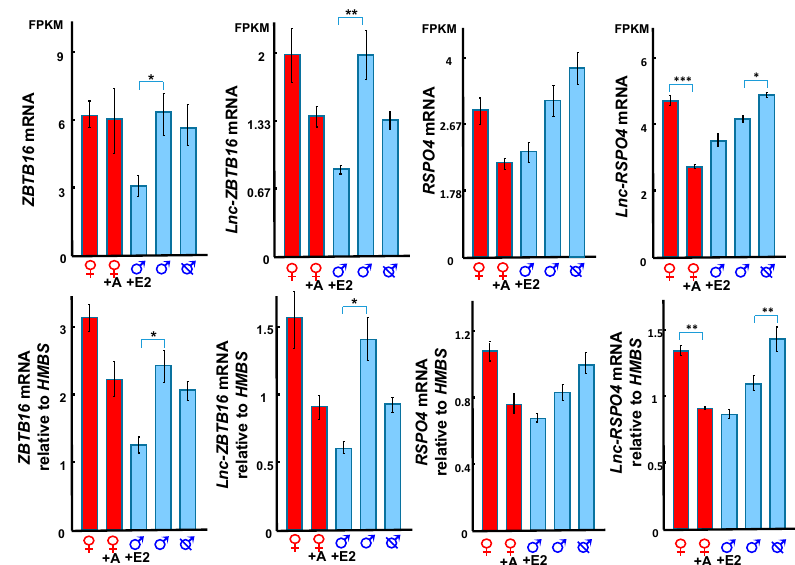
Figure 6. ZBTB16 , lnc-ZBTB16 , RSPO4 and lnc-RSPO4 transcript expression from RNA-Seq (top) and gene expression validated by qPCR (bottom). ZBTB16 and lnc-ZBTB16 were both downregulated by oestrogen in males. Lnc-RSPO4 was downregulated in females by adiol treatment, but upregulated in males after castration. A: androgen, E2: oestrogen. FPKM: Fragments Per Kilobase of transcript per Million mapped reads. *: p < 0.05, **: p < 0.005, ***: p < 0.001. Error bar: SEM.